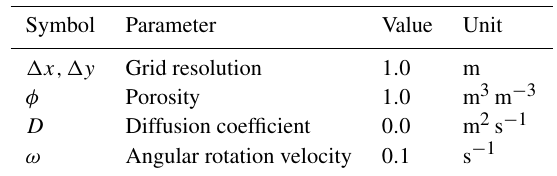
Figure 3. Spatial model dimensions, initial tracer concentration and prescribed spatial velocity field used for the rotating cone test. Contour lines show the initial shape with a maximum of C = 3 . 87kgm − 3 and the exact location of the 30m diameter cone, while the filled contours and streamlines illustrate the prescribed spatial velocity distribution. Table 3. Rotating cone test parameters adapted from Smolarkiewicz